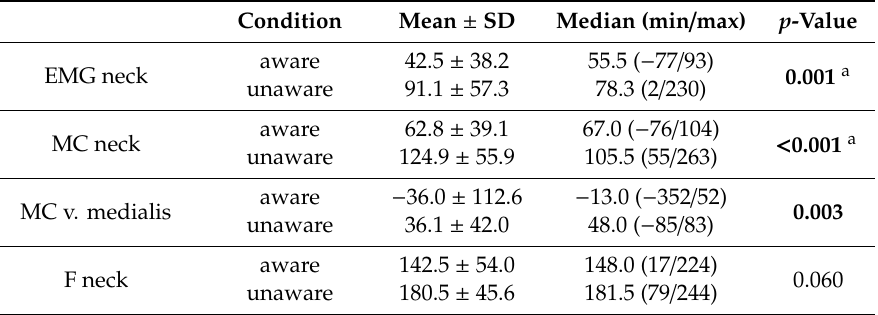
Table 4. Onset latencies for EMG, MC neck, MC vastus medialis, and neck-muscle load F from the instant of the impact [ms]; mean ± SD, median (min/max), p -value for pairwise comparisons between aware and unaware conditions.